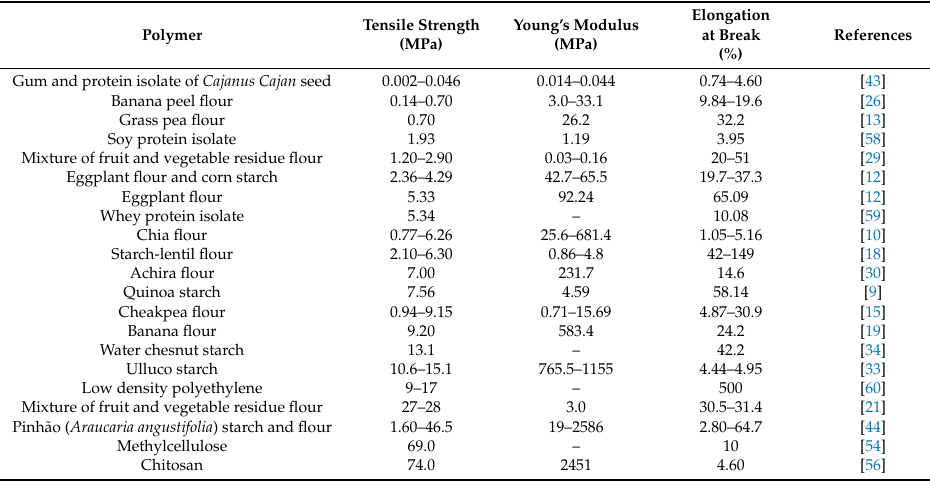
Table 2. Mechanical properties of selected biopolymer and plastic films.